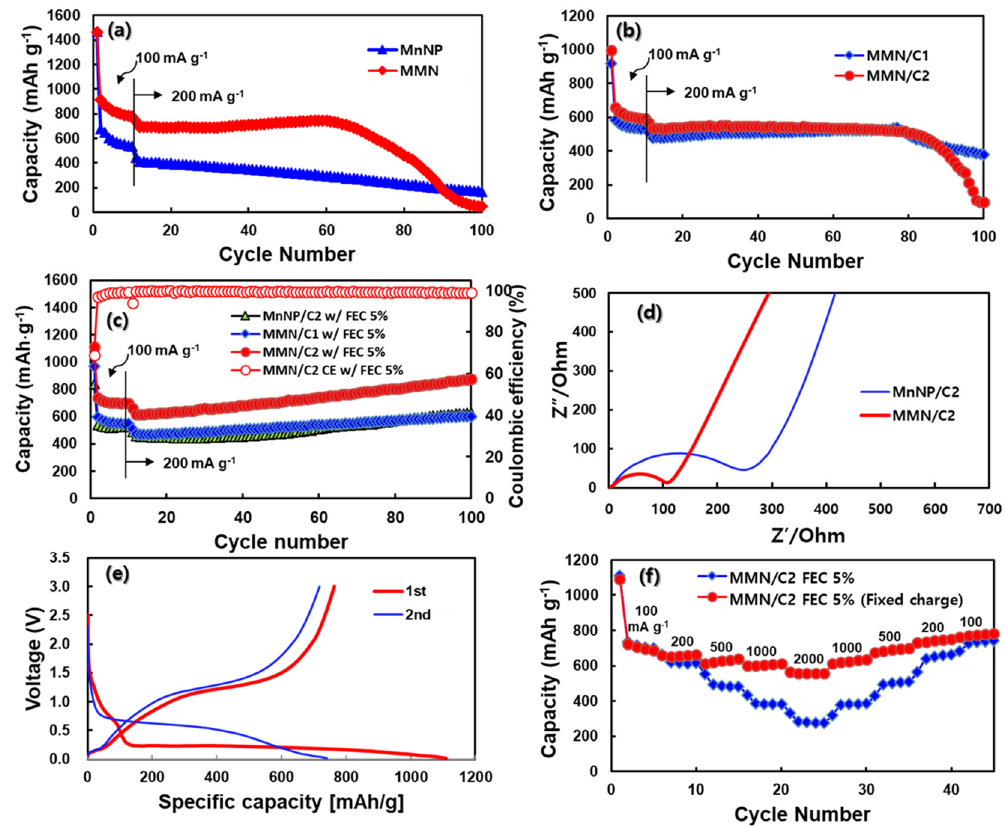
Figure 5. Cycling performances of ( a ) MnNPs and MMN with electrode formulation of AM:carbon black (CB):binder = 5:4:1, ( b ) MMN/C1 and MMN/C2, and ( c ) MnNP/C2, MMN/C1, and MMN/C2 with FEC (5%) containing electrolyte, ( d ) Nyquist plots of MnNP/C2 and MMN/C2, ( e ) charge and discharge voltage profiles of MMN/C2 for the initial two cycles, and ( f ) rate responses of MMN/C2 with current density changes for both charging and discharging processes at the same time (filled diamond) or for discharging process only at fixed charging current (100 mA g − 1 ) (filled circle).